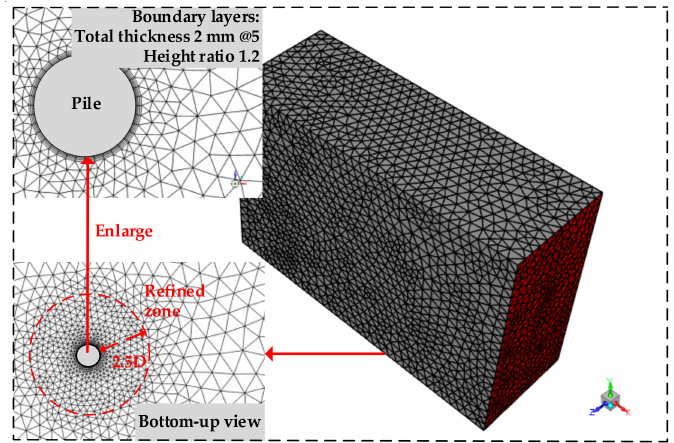
Figure 3. The mesh of the model.